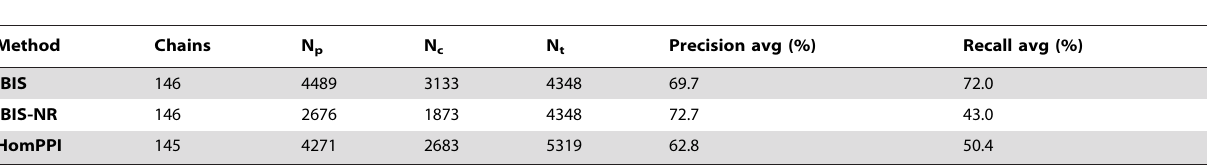
Table 2. Comparison of IBIS with other protein-protein interaction prediction methods.